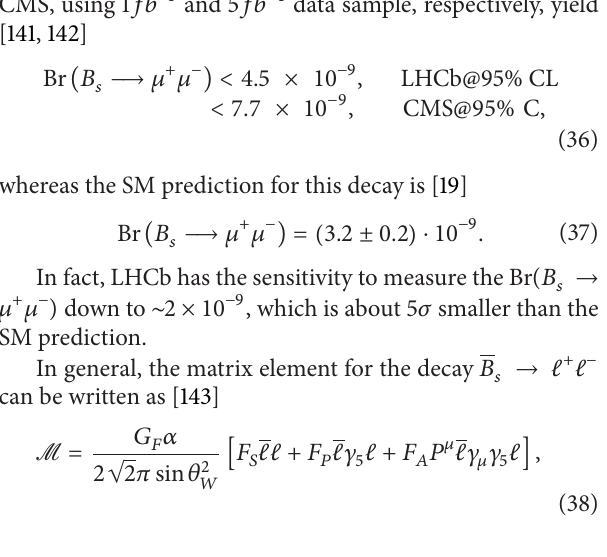
Figure 13: The muon 𝑔 − 2 as a function of the product 𝛿 Σ = 700 GeV (b). The horizontal lines are the measured 1 − 𝜎 bounds on 𝑎 𝑚 𝐻 +